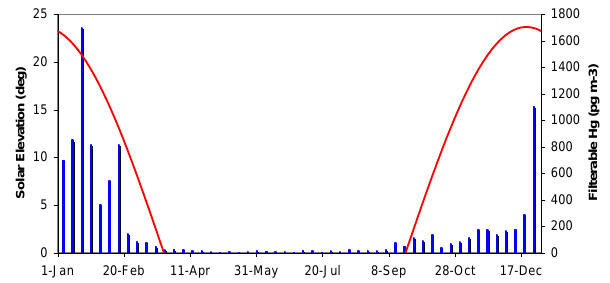
Fig. 3. Weekly averages of total filterable (the sum of RGM and PHg) mercury concentrations (bars) collected as Hg on high volume filters, and the annual solar elevation angles (line) at South Pole Station. High volume filters allow Hg(0) is pass but collect PHg and a significant portion of the RGM (after Brooks et al.,